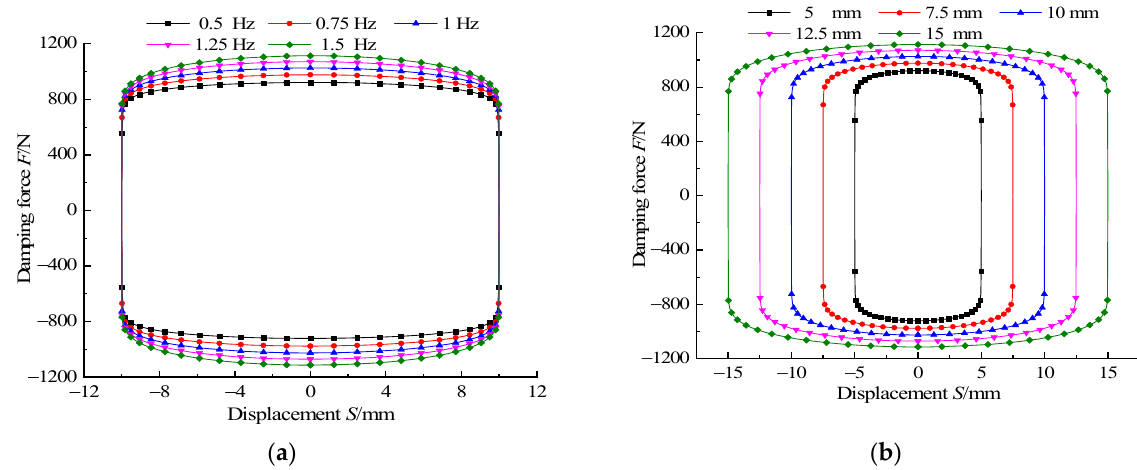
Figure 16. Damping force versus displacement at different sinusoidal excitation at ( a ) different frequencies and ( b ) different amplitudes.